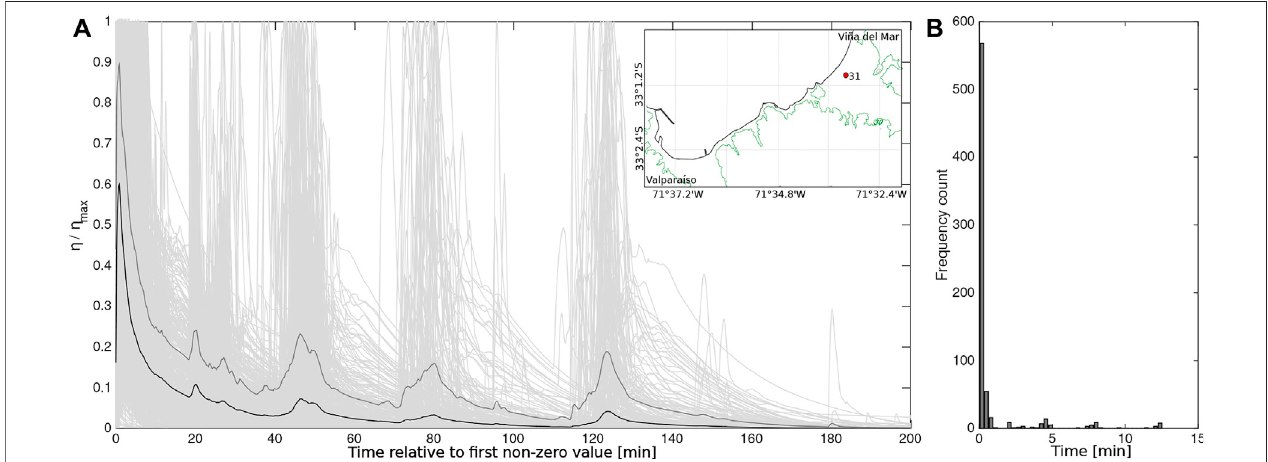
FIGURE8 | Arrival times at point ofinterest (POI) ID 31 (A) Time series of thenormalized fl ow depth of2,800 scenarios recorded at POI31shown in theinset map. The assessment is done considering inland arrival with time relative to the fi rst non-zero value. Black line shows the mean and darker grey shows the standard deviation (B) Frequency of the time difference between the maximum amplitude arrival and the fi rst amplitude arrival at POI 31.